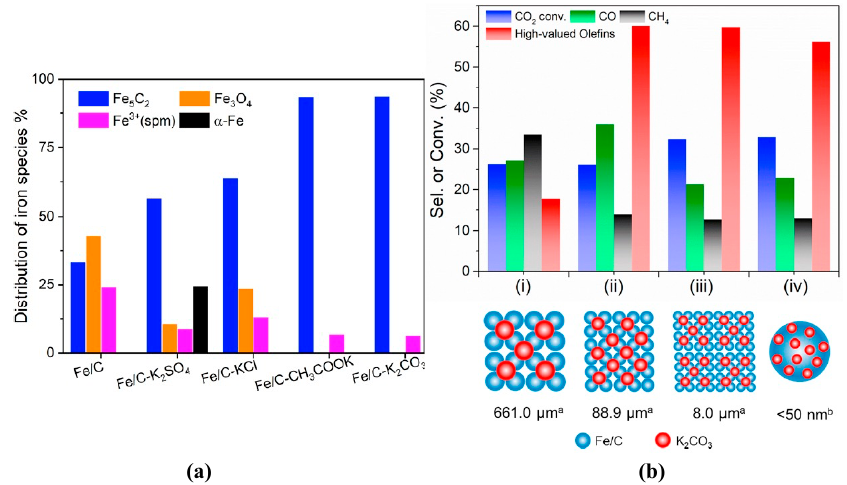
Figure 7. ( a ) Distribution of iron species content over different spent catalysts. ( b ) CO 2 hydrogenation over Fe/C − K 2 CO 3 catalysts with varying proximity. Adapted with permission from ref. [94].